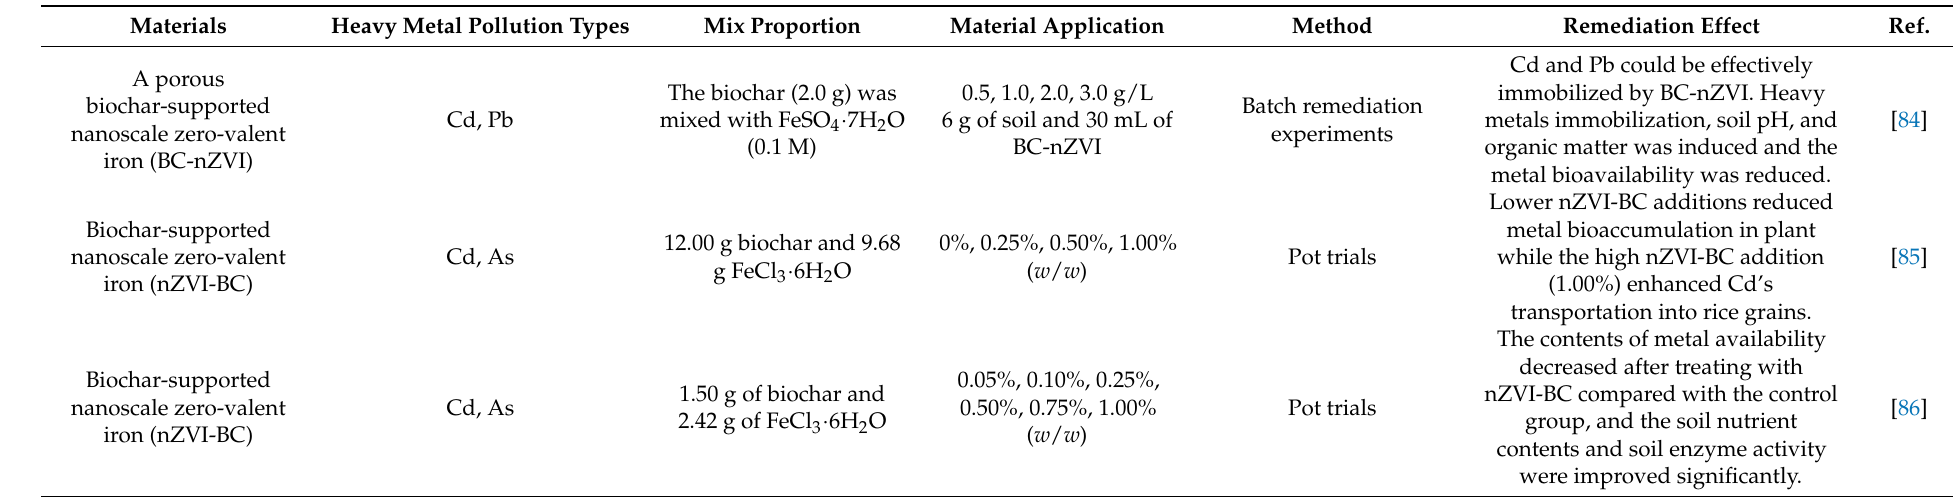
Table 4. Remediation of Cd-contaminated soils by biochar-supported